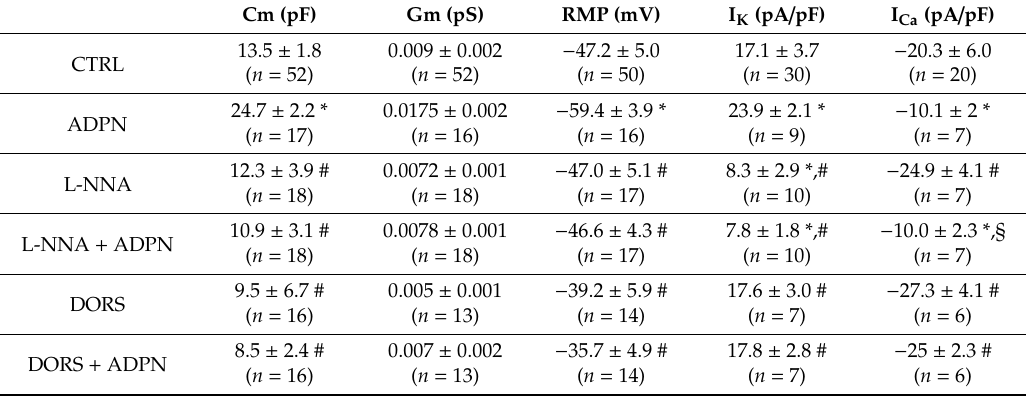
Table 1. Passive membrane properties and normalized ion current amplitude (current response evoked by the + 50 mV pulse) of gastric fundus SMCs in the di ff erent